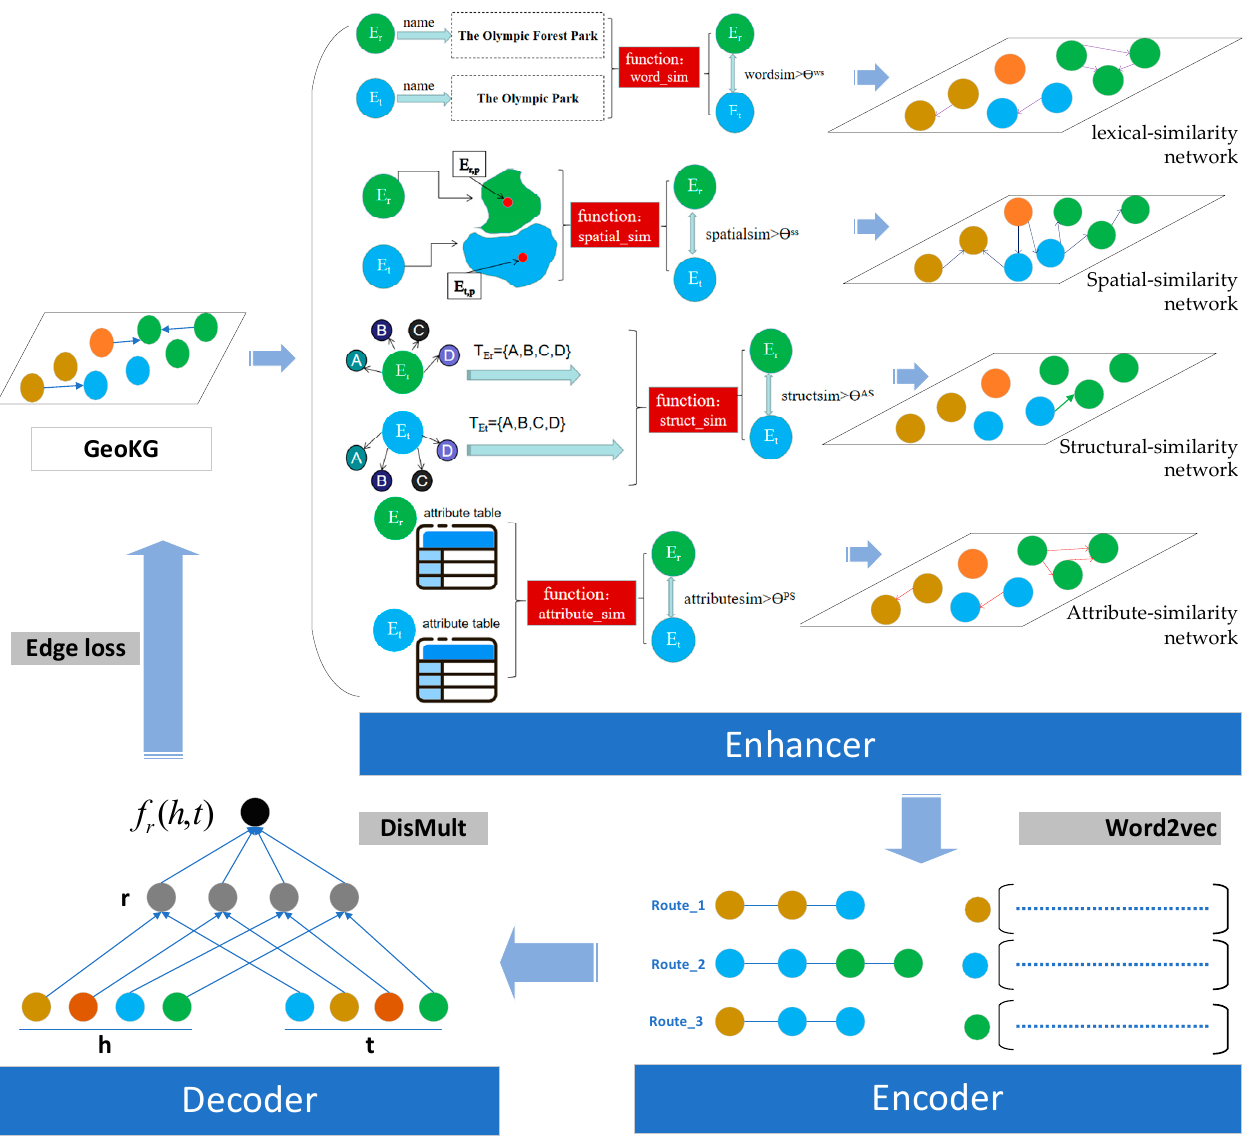
Figure 2. Framework of